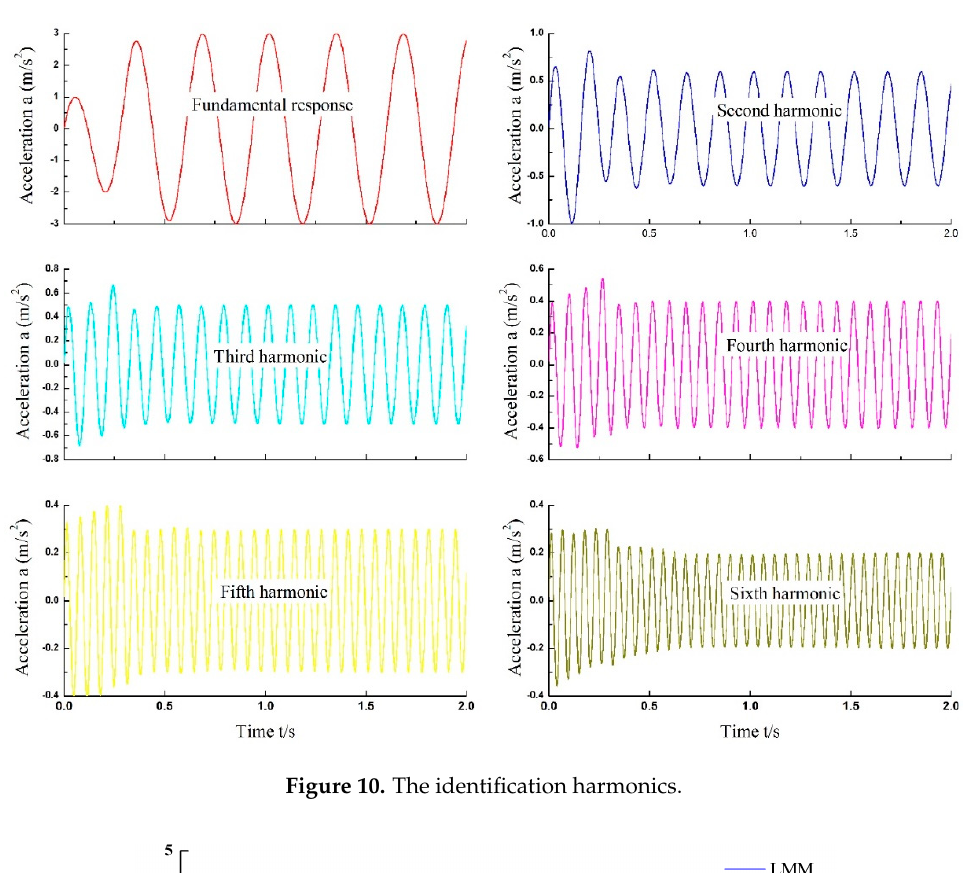
Figure 10. The identification harmonics.